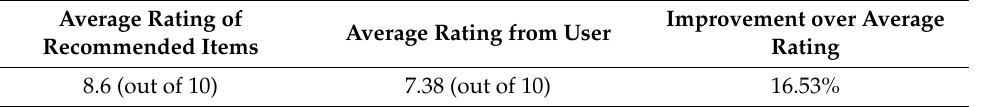
Table 8. Results of the recommended item average.